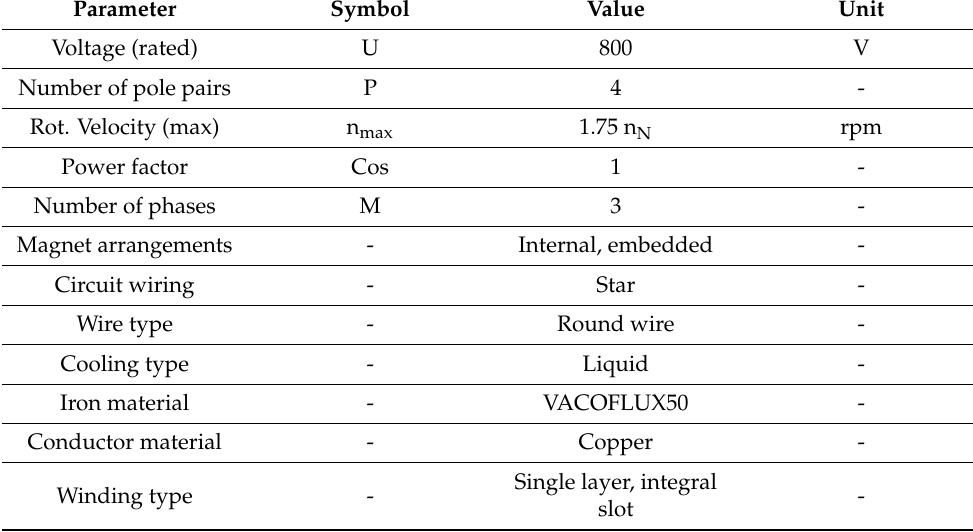
Table 5. Assumptions of input parameters for the machine design tool MEAPA